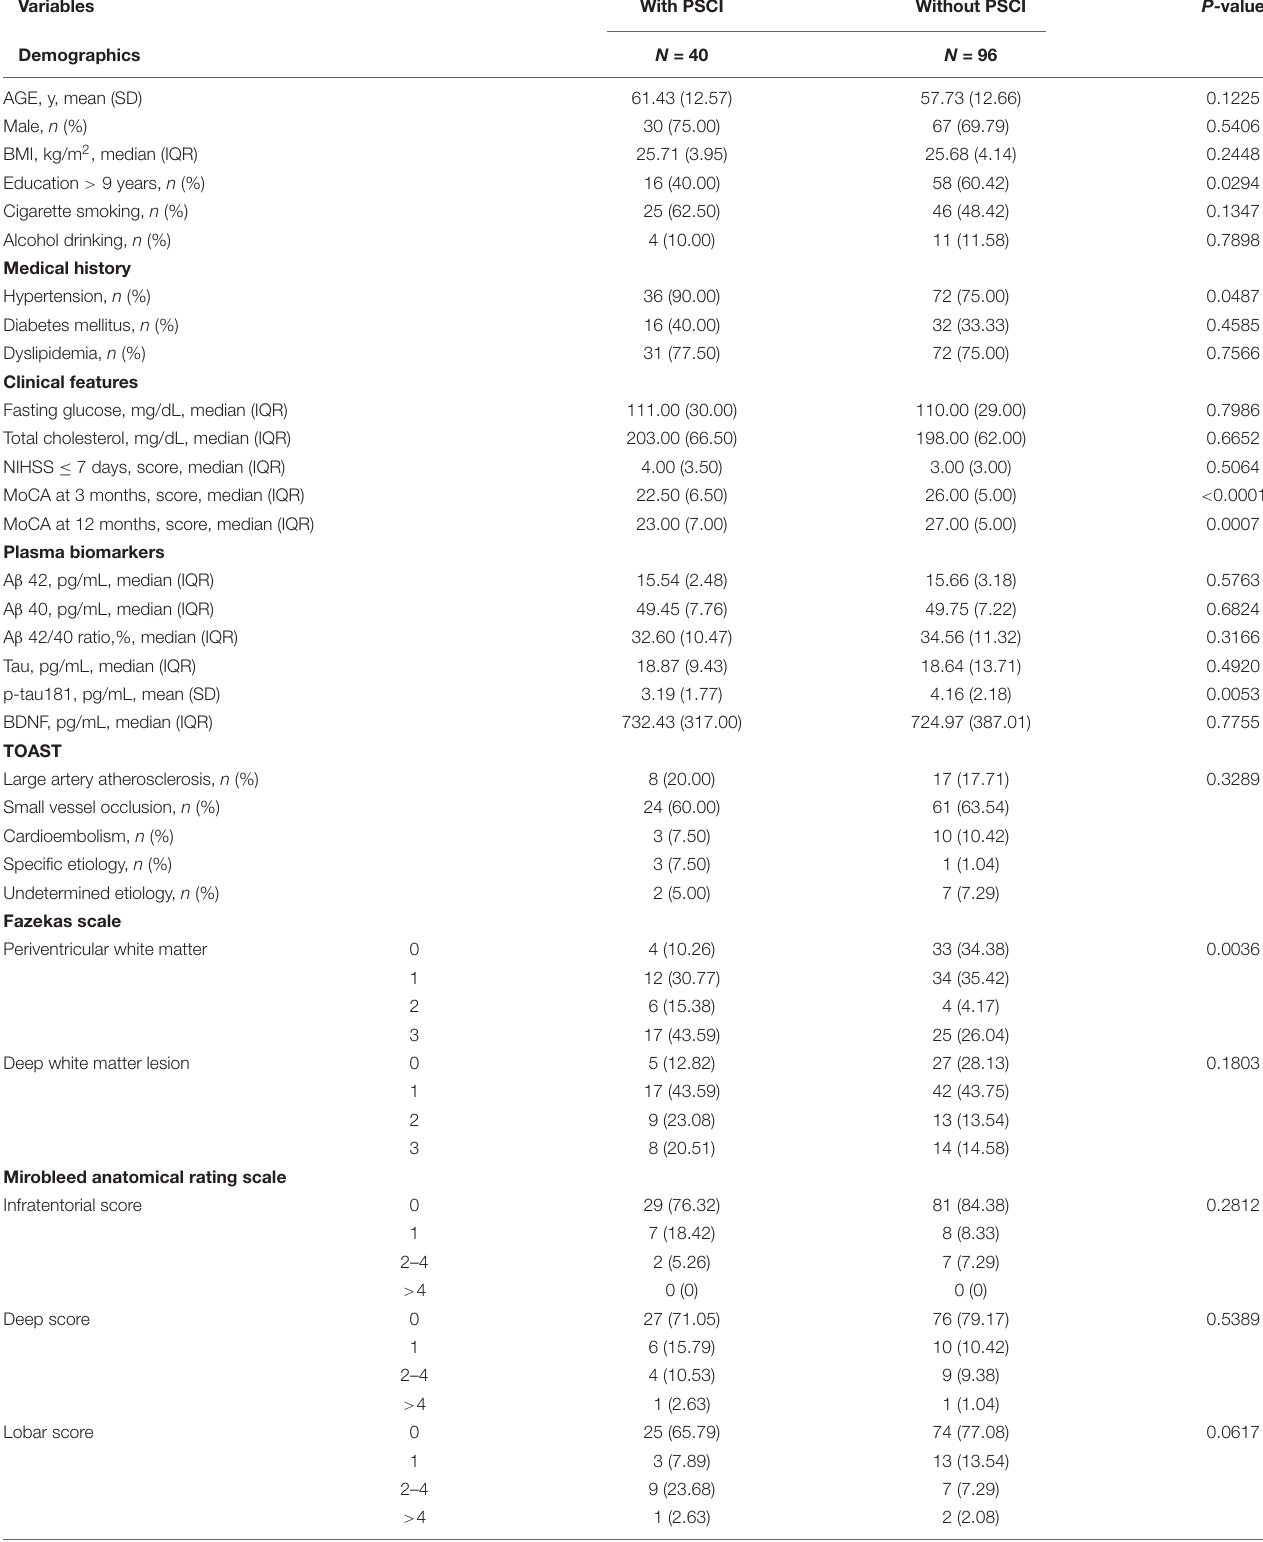
TABLE 1 | Basic characteristics of study subjects with and without PSCI defined at 3 months after stroke.